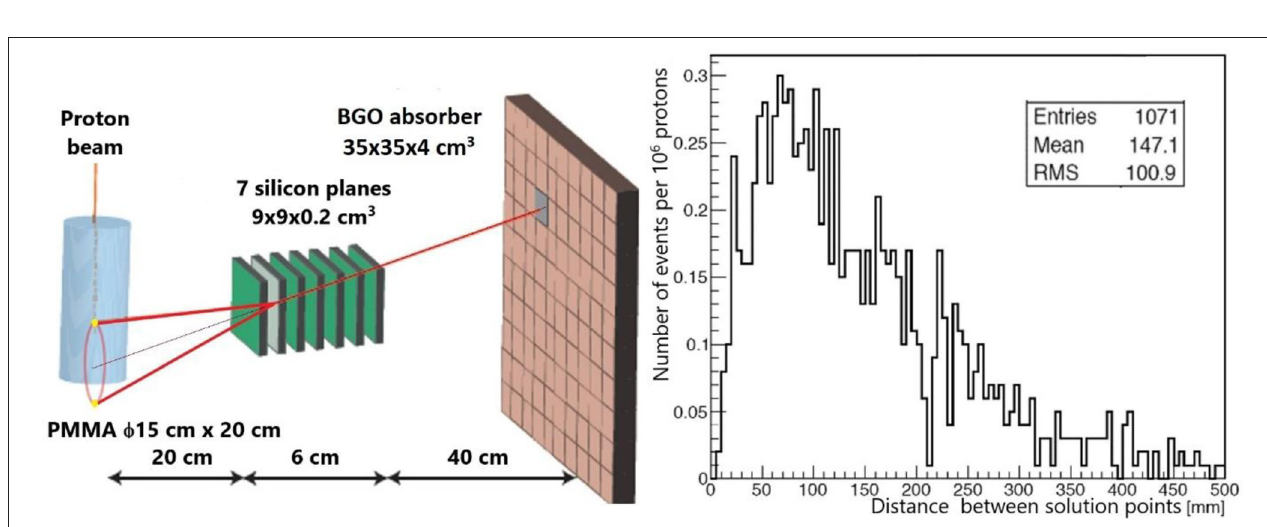
10 8 protons, data from [ 21] with authors permission, with and without a 2cm air cavity at × 3 10 8 ) [ 24]. ∼ ×